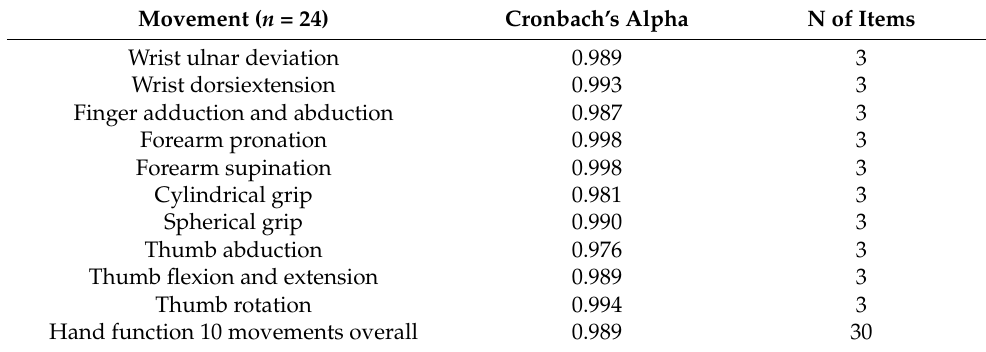
Table 1. Reliability of MDIVQAS for assessing hand functions.